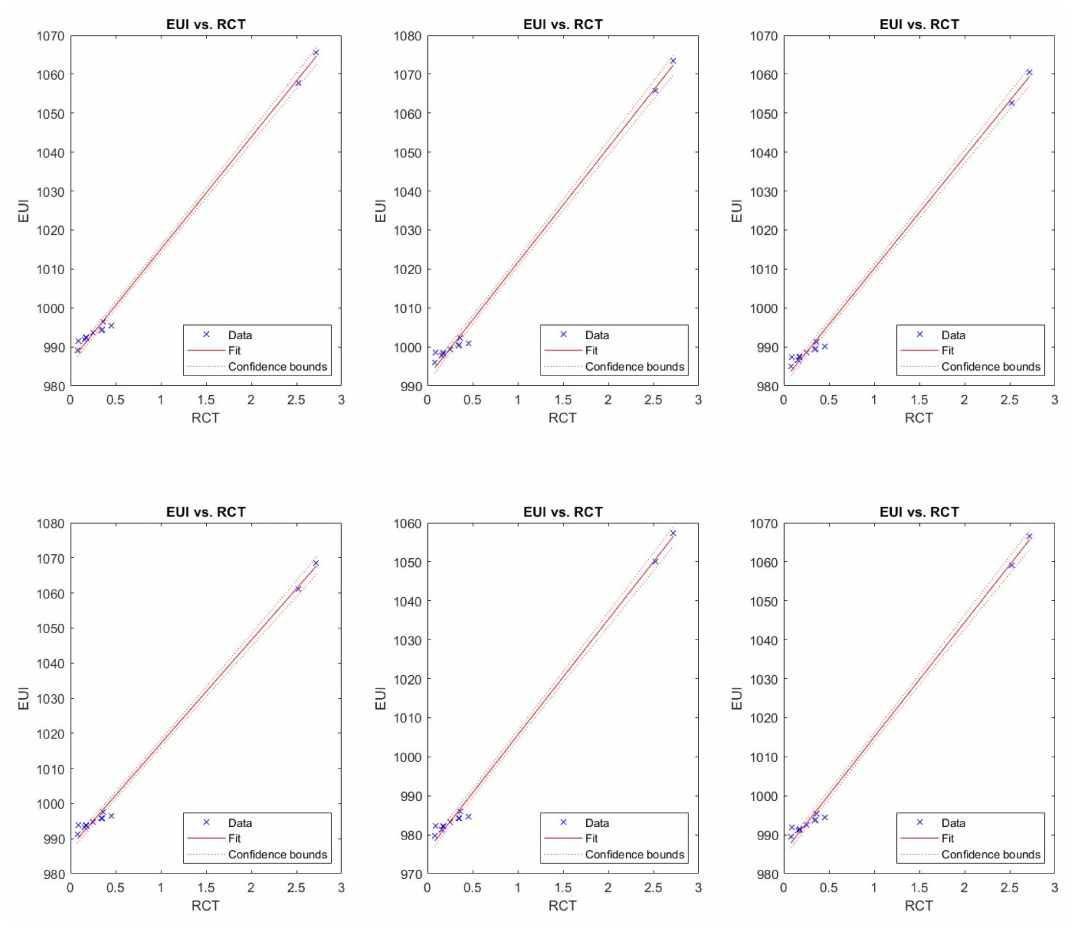
Figure 14. Fitted lines of roof construction type